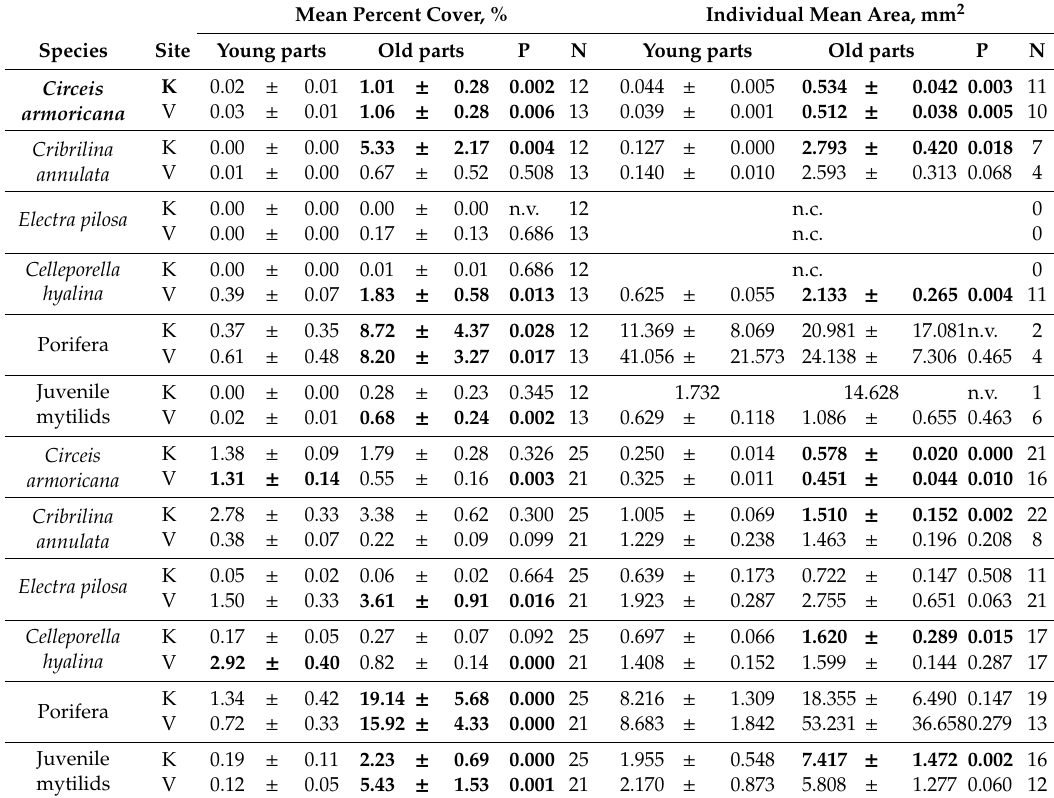
Table 4. Mean percent covers and mean individual sizes (approximated area occupied) of top abundant species on young and old parts of the same Phycodrys rubens pairwise compared (Wilcoxon matched pairs test, P). K—Site K, V—Site V. n.v.—no variance or sample size too small. n.c.—no co-occurrence on old and young parts of a single plant. N—sample size. Significantly higher mean in a pair highlighted in